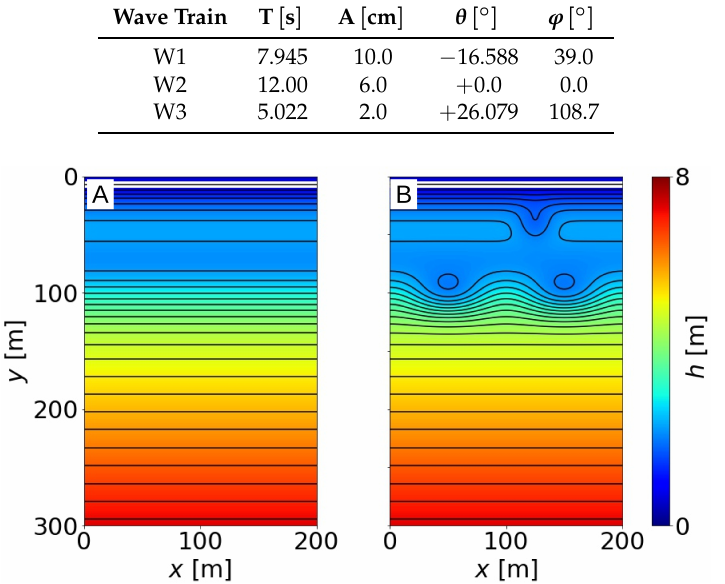
Figure 5. Bathymetries (in meters) for the analysis of linear waves ( A ) and nonlinear waves ( B ): The white strip next to the shore highlights h = 0.75 m.